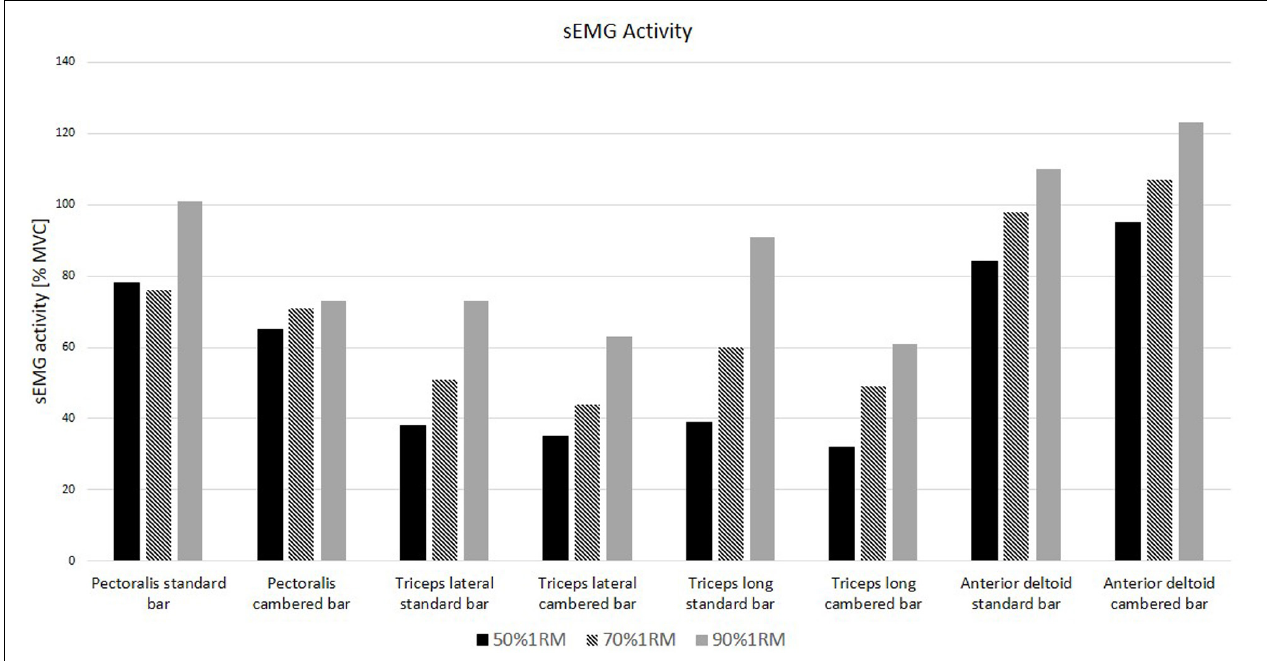
FIGURE 2 | sEMG activity of selected muscles during bench press under different external